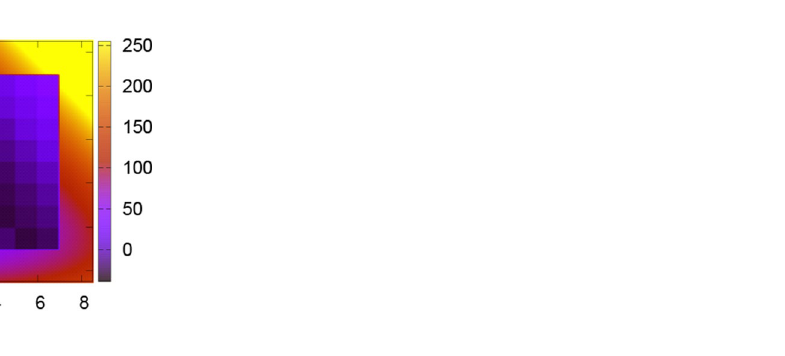
Table 1. Local energy per four-atom unit cell of each composition in units of eV. The values inside the parentheses are the local free energy including the effect of the potential renormalization (cid:31) F ren at 1300 K. The 4 4 4 supercell results are also listed for bcc Ti 4 and V 4 . a See Ref. 21 . × ×